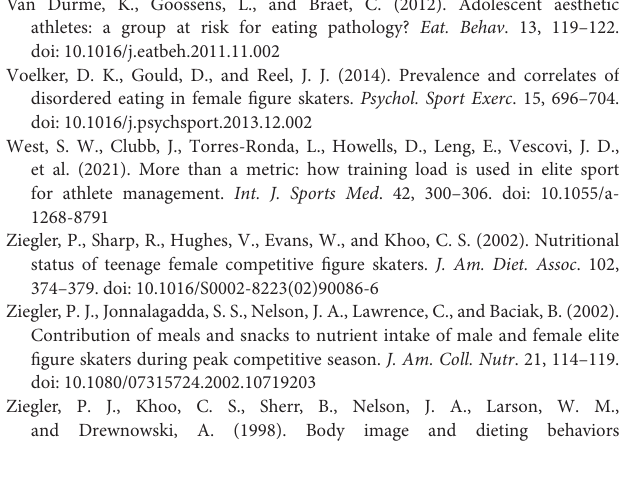
among elite figure skaters. Int. J. Eat. Disord . 24, 421–427. doi: 10.1002/(SICI)1098-108X(199812)24:4 < 421::AID-EAT9 > 3.0.CO;2-H